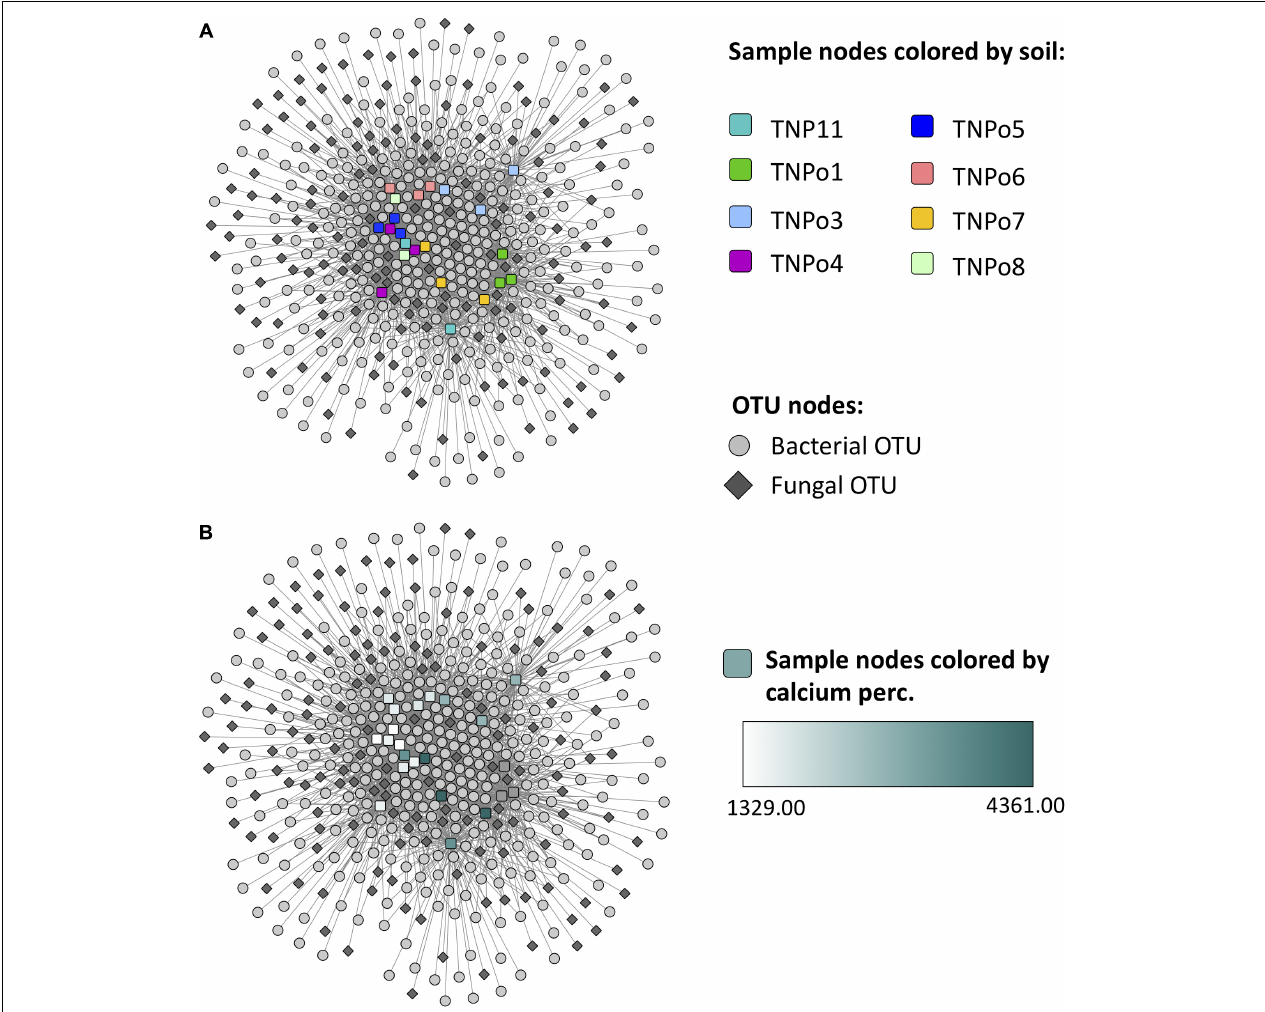
FIGURE 8 | Operational taxonomic unit (OTU)-sample enrichment networks representing the enrichment of OTUs in samples for Experiment 2: Soil origin. An OTU node is connected to a sample node via an edge if the OTU is significantly enriched in that sample. Sample nodes are colored by (A) soil and (B) calcium